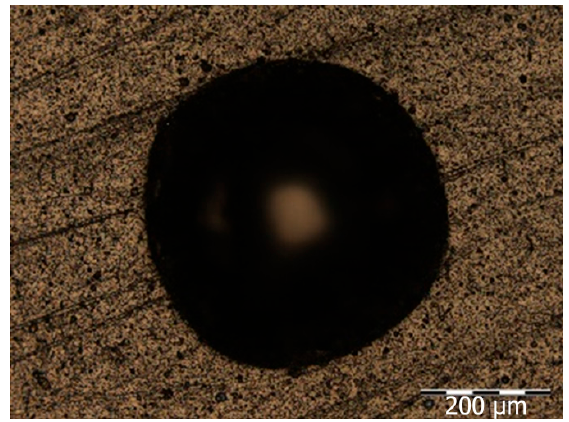
Figure 12. D4 adhesion results.